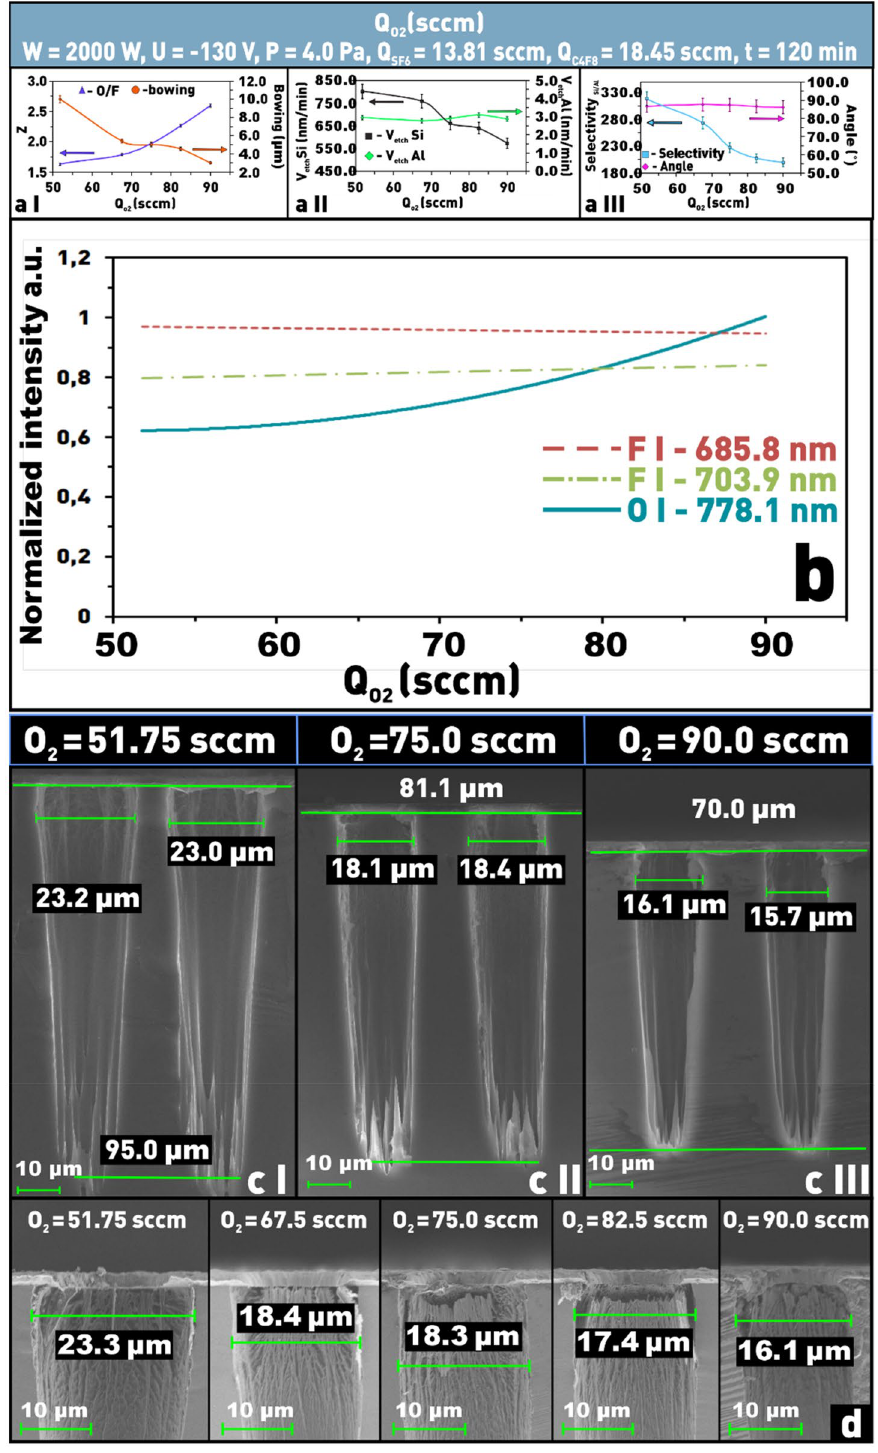
Figure 7. Dependences on the Q O2 in SF 6 /C 4 F 8 /O 2 plasma: ( a I ) of δ and Z parameters; ( a II ) of etching rate of silicon and aluminum; ( a III ) of etching selectivity and the angle Θ; ( b ) dependences of the emission intensity of fluorine lines (685 8 and 703.9 nm) and oxygen (778.1 nm) as a function of the Q O2 ; ( c I – III ) microphotographs of the etching windows profiles at different oxygen contents; ( d ) microphotographs of etched windows at different contents of O 2 in SF 6 /C 4 F 8 /O 2 plasma to evaluate the structure overetching